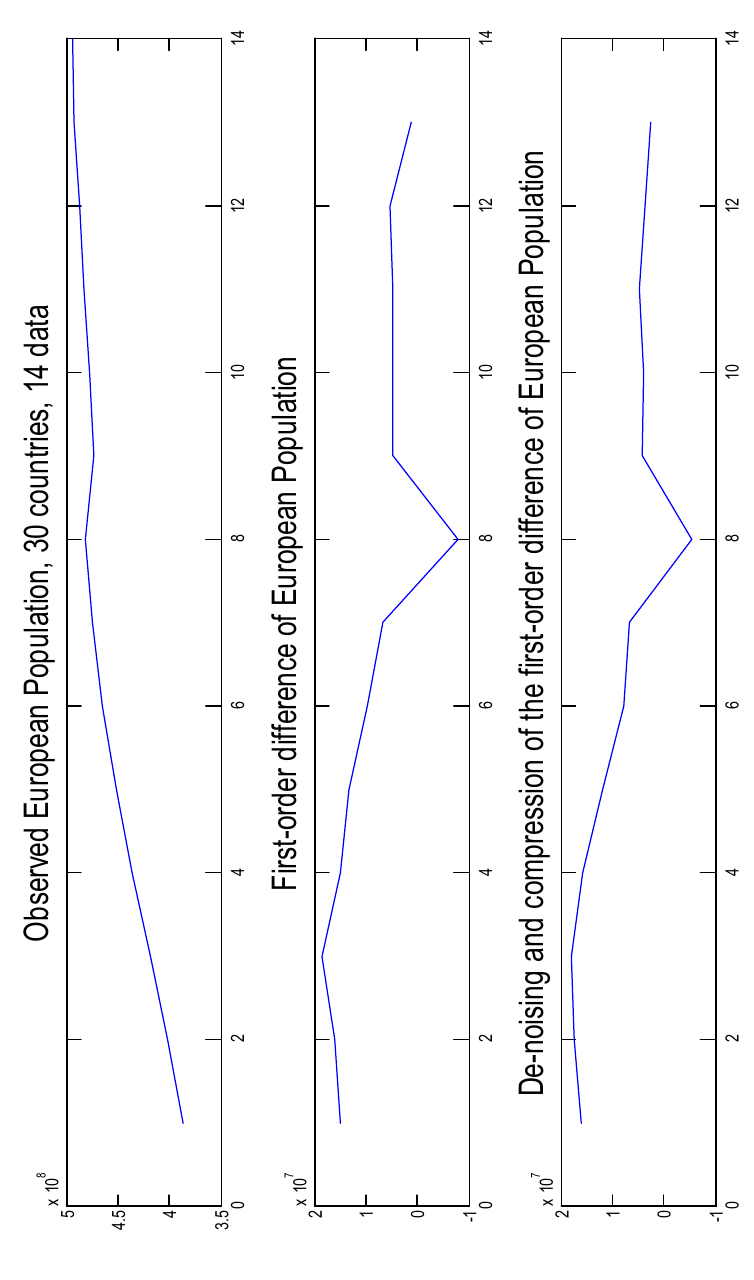
Figure 2. Observed European total population (30 countries) from 1950 to 2015 (14 data, top), fi rst-order difference of the European total population (middle), de-noising and compression of the fi rst-order difference of the European total population